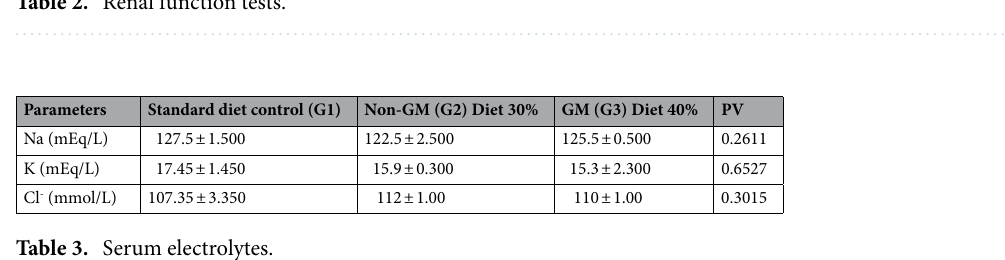
Table 2. Renal function tests.